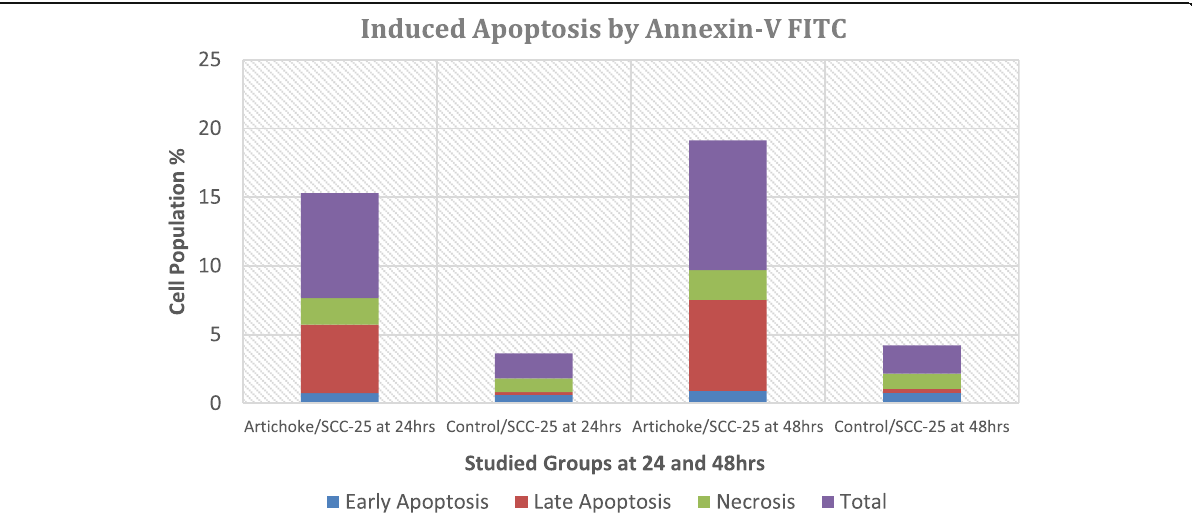
Fig. 3 Percentage of cell populations by annexin-V FITC flow cytometry analysis in both control- and artichoke-treated SCC-25 that demonstrate